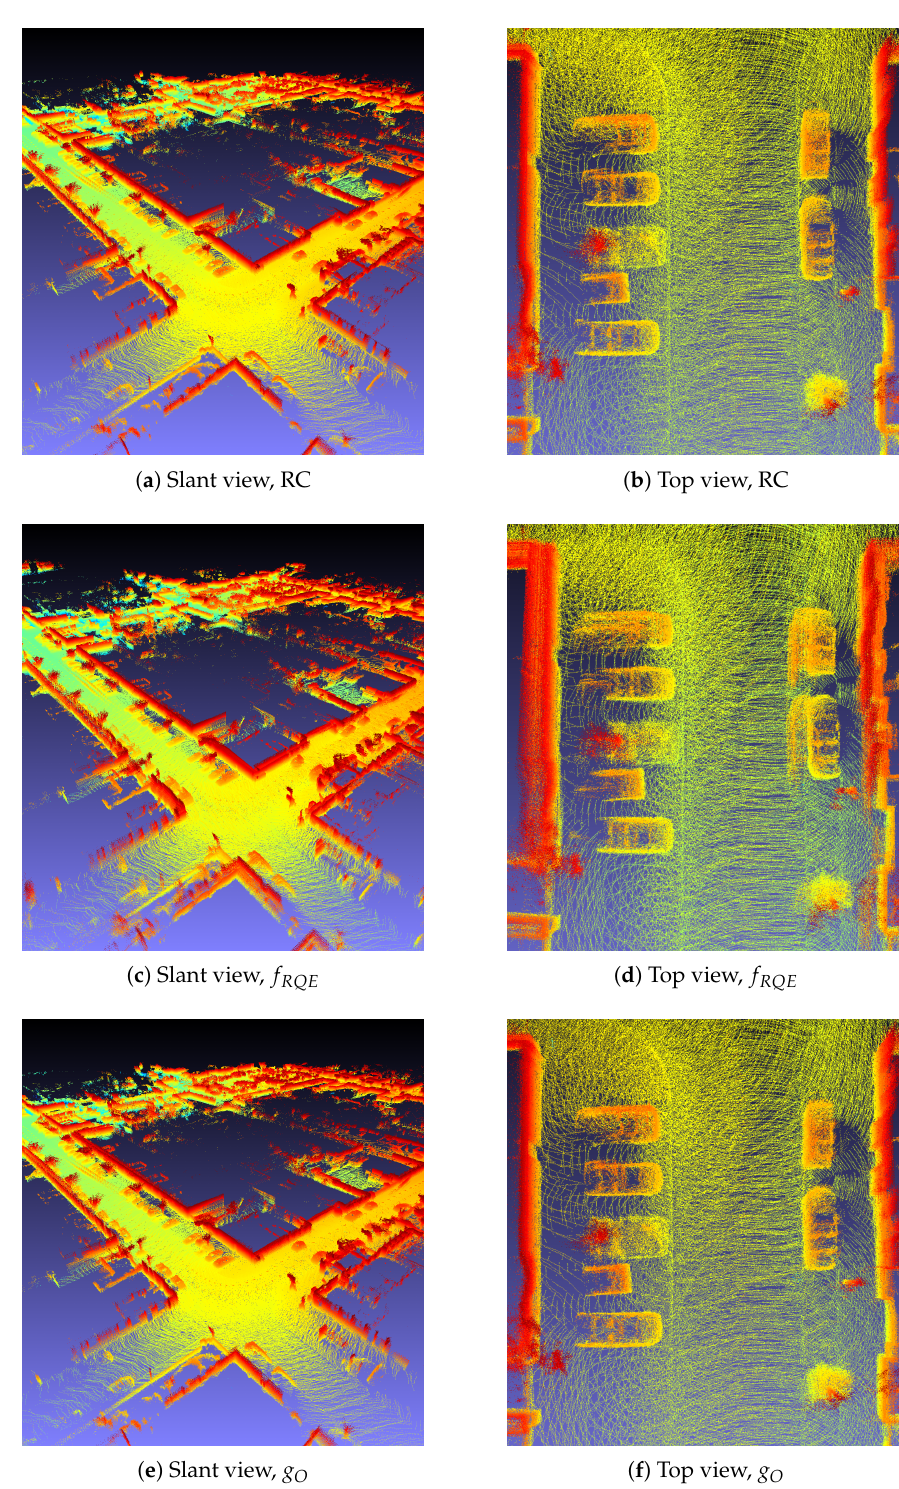
Figure 9. Results on the publicly available KITTI dataset [44]. The color of each point depicts its height. Both calibrations improved the initial calibration parameters such that objects and basic structures are identifiable in the point clouds. Moreover, the RC and the calibration based on the feature of omnivariance lead to very similar point clouds. The calibration based on the f RQE , however, results in a more noisy point cloud, which can be seen especially at the vertical walls and at artifacts next to the two cars on the